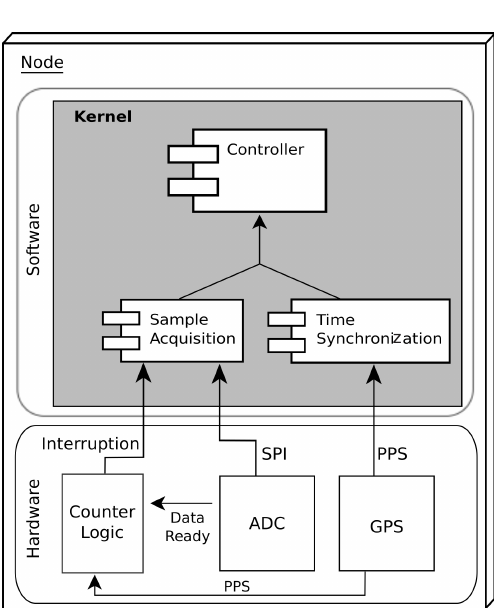
Fig. 8: Data acquisition board Figure 8. Data acquisition